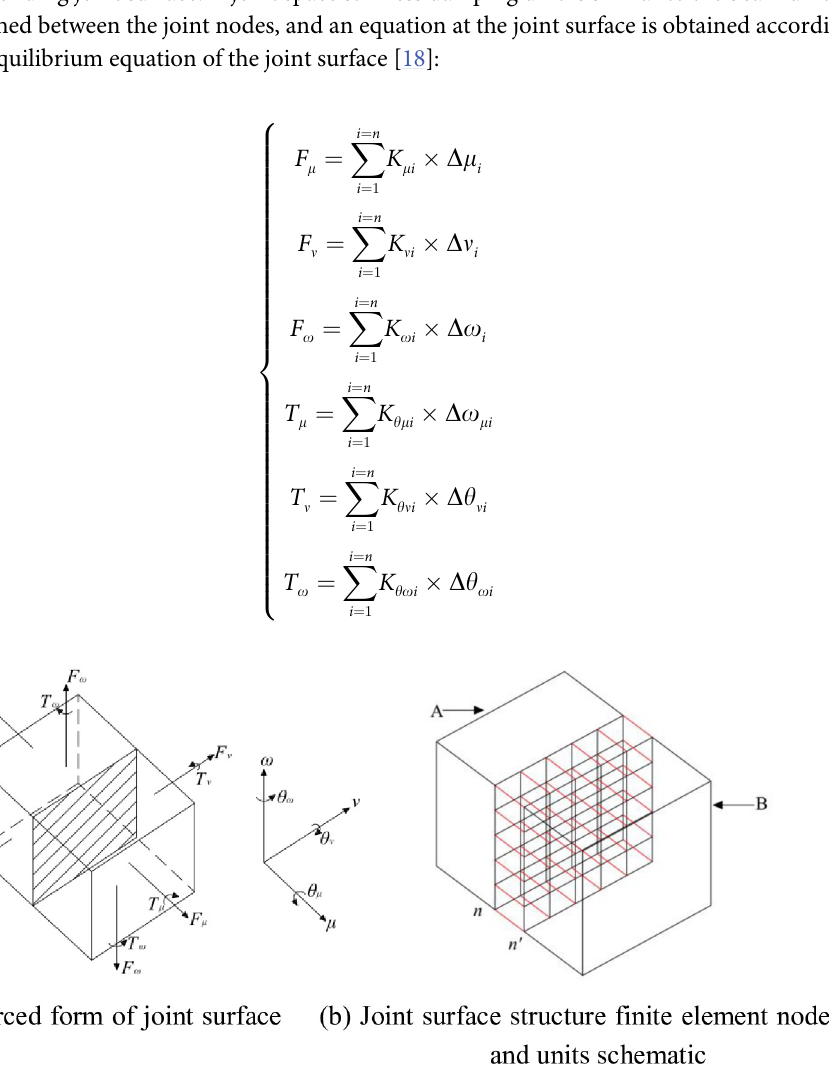
Fig 1. Joint surface of an actual woodworking machine structure. (a) Forced form of joint surface, (b) Joint surface structure finite element nodes and units schematic.